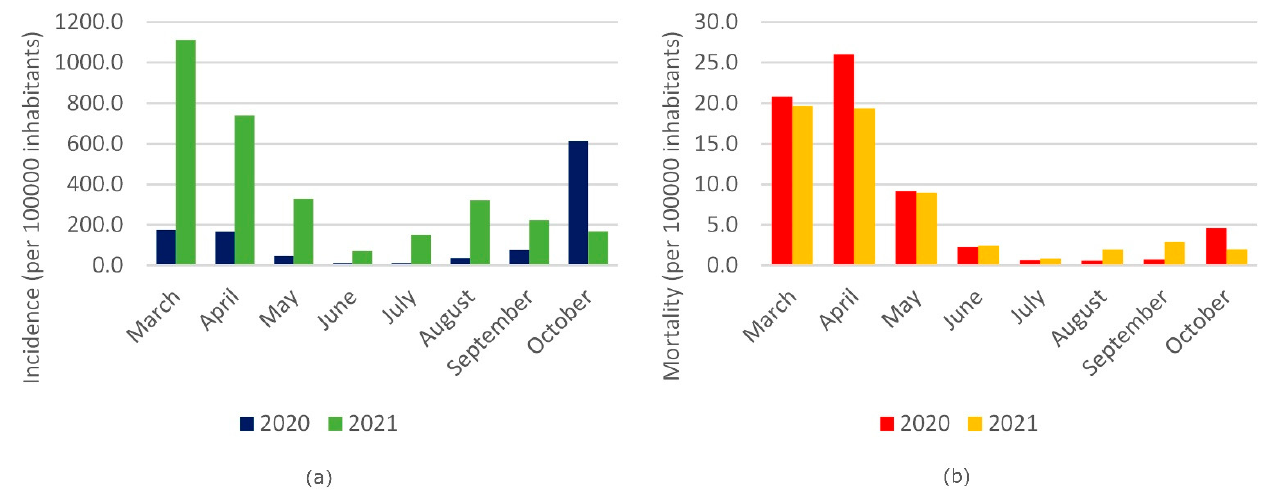
Figure 2. ( a ) Comparison of the cumulative incidence in the Italian population (per 100,000 inhab- itants, range scale 0.0–1200.0) in 2020 and 2021 for the period March–October. ( b ) Comparison of mortality rate in the Italian population (per 100,000 inhabitants, scale range 0.0–30.00) in 2020 and 2021 for the period March–October.